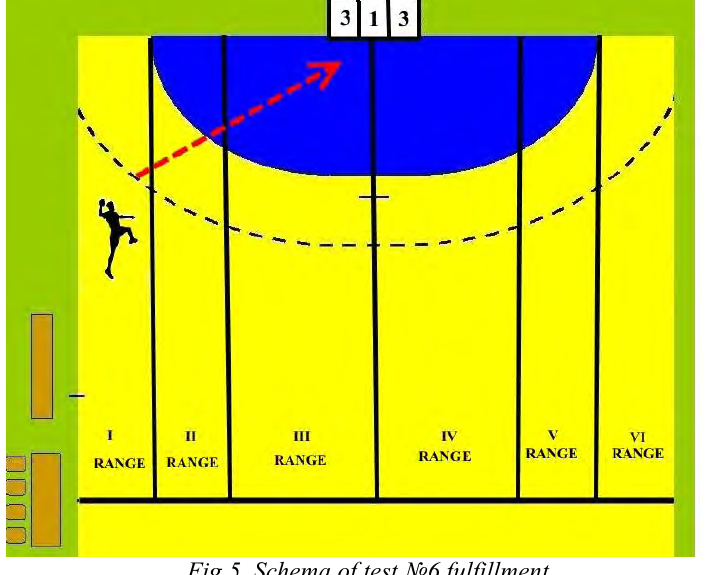
Fig.5. Schema of test №6